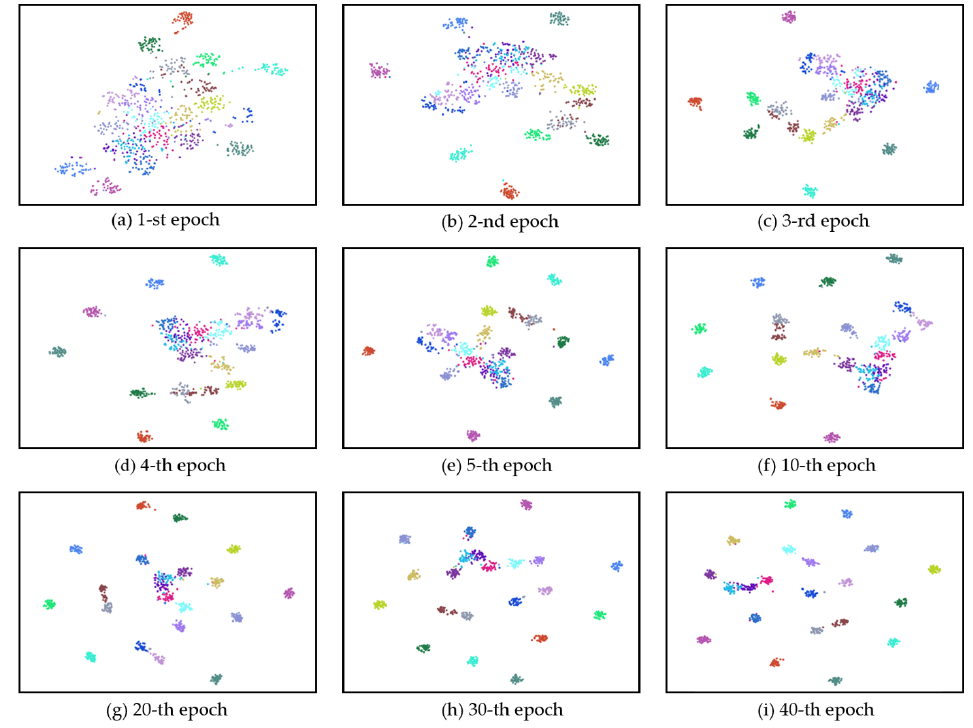
Figure 18. A t-SNE visualization of the proposed method. ( a – e ) are the t-SNE visualizations of the first five epochs of all classes in the dataset UCMD. ( f – i ) are the t-SNE visualizations at the 10th, 20th, 30th, and 40th epochs, respectively. Different colors in the diagram represent different